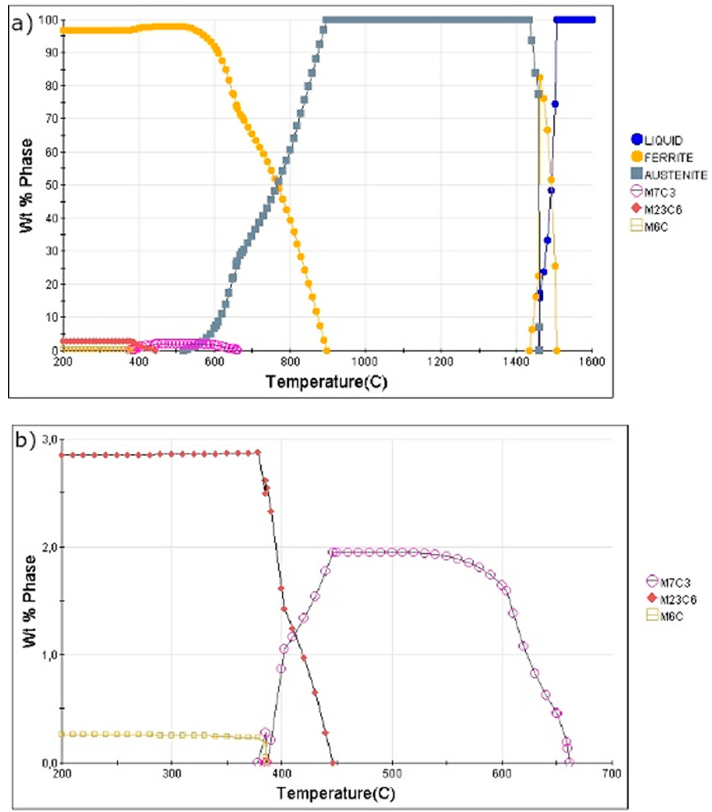
Figure 2. Phase evolution diagram of the steel in equilibrium conditions: ( a ) full diagram; ( b ) left bottom magnified part of the diagram.